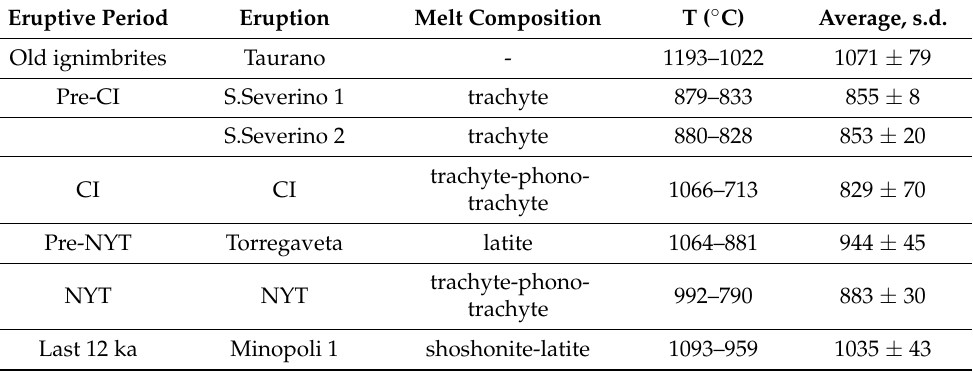
Table 7. Temperature output obtained from the two-feldspar geothermometer applied to plagioclase- and K-feldspar-melt couples resulted in